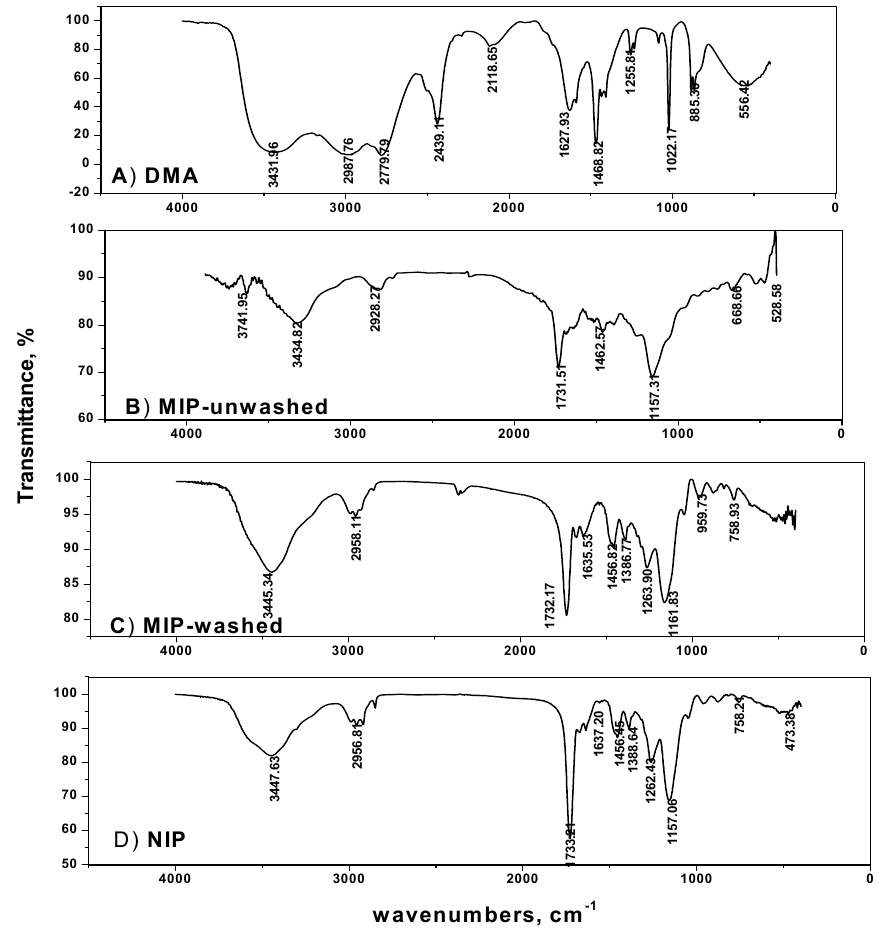
Figure 2. Spectra of: ( A ) DMA, ( B ) MIP-unwashed, ( C ) MIP-washed and ( D ) NIP.